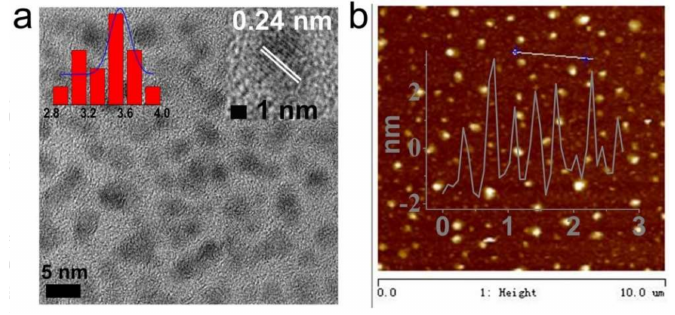
Figure 1. ( a ) Size distribution (inset of a, left) and high-resolution (HR)TEM (inset of a, right) images of CDs-1; ( b ) AFM image and topographic heights of CDs-1.